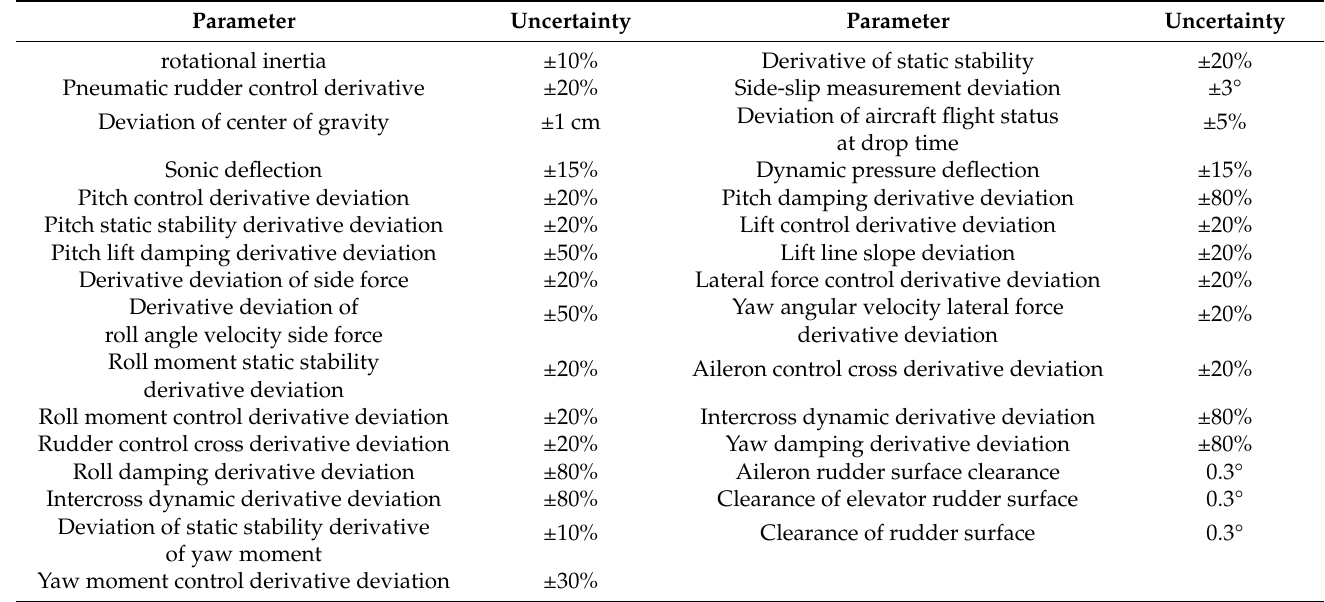
Table 5. Parameter perturbation simulation of supersonic